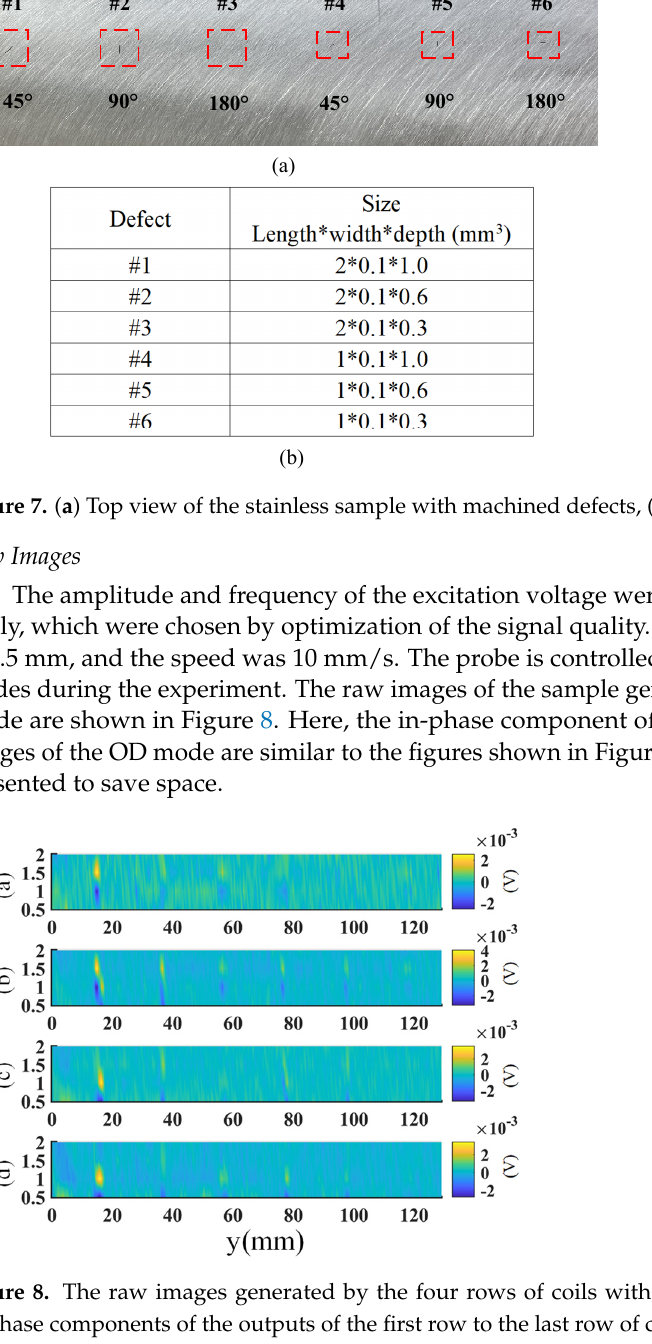
(V) Figure 6. Simulation results: images of the horizontal defect with different spatial resolutions: ( a ) 2 mm, ( b ) 1 mm and ( c ) 0.5 mm. 3. Experiment Setup